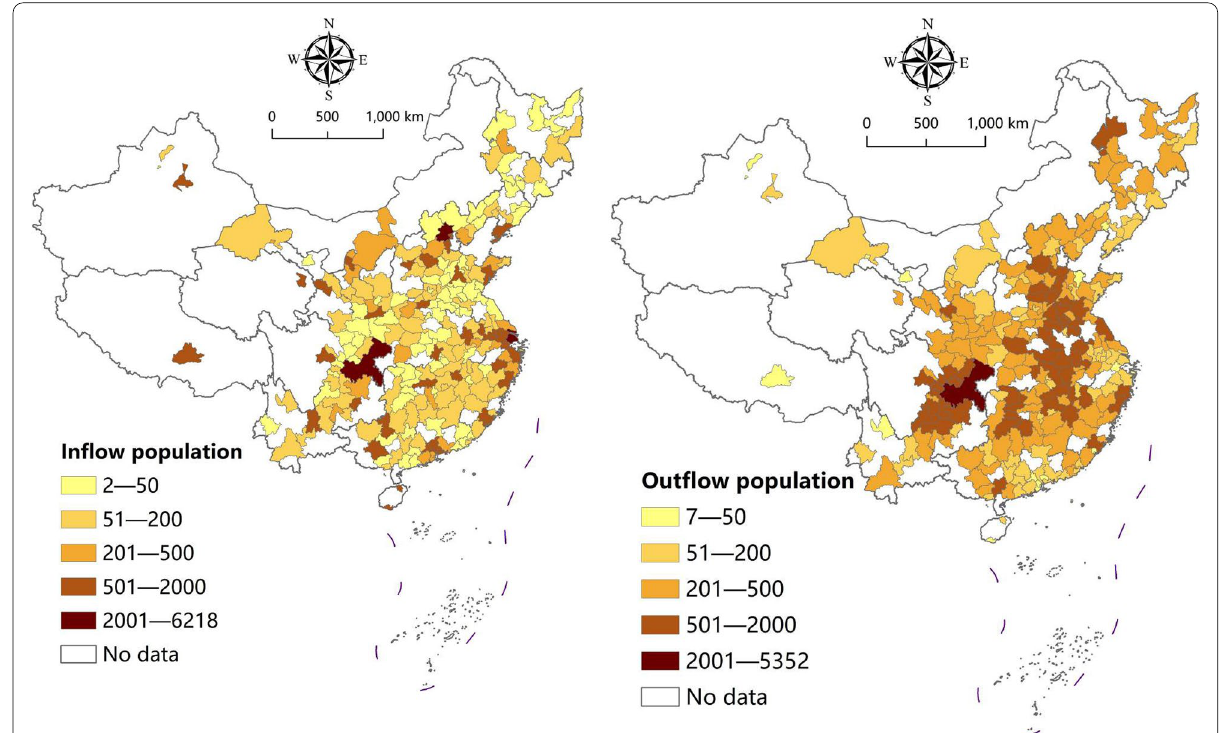
Fig. 1 In-migration and out-migration of the floating population in China. Data source: China Migrants Dynamic Survey (CMDS;